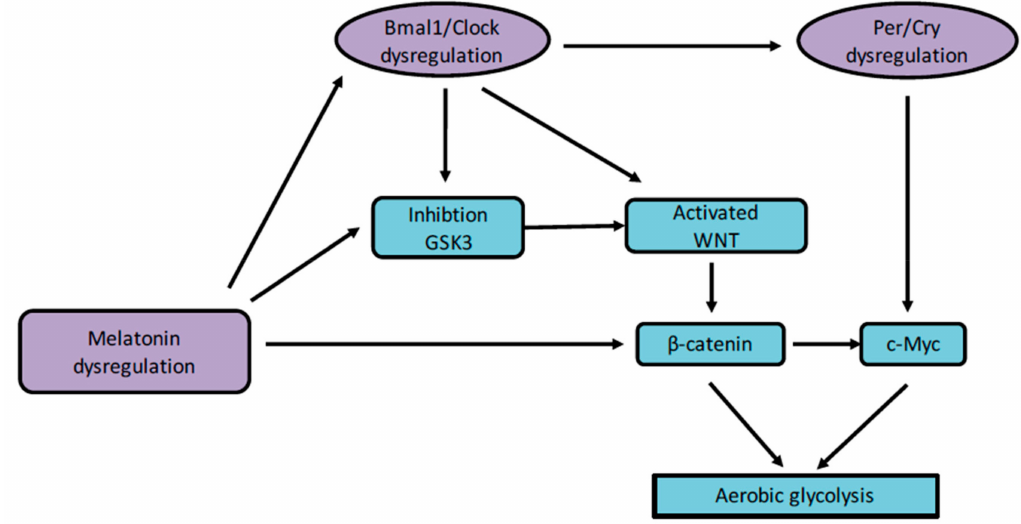
Figure 3. CRs and aerobic glycolysis. The dysregulation of melatonin and circadian clock genes leads to the activation of WNT and inactivation of GSK3 . The WNT pathway enhances β -catenin accumulation and then, its nuclear translocation. Activation of the β -catenin pathway leads to aerobic glycolysis. Abbreviations: circadian locomotor output cycles kaput ( Clock ), brain and muscle aryl-hydrocarbon receptor nuclear translocator-like 1 ( Bmal1 ), period ( Per ), cryptochrome ( Cry ), glycogen synthase kinase-3 β ( GSK-3 β